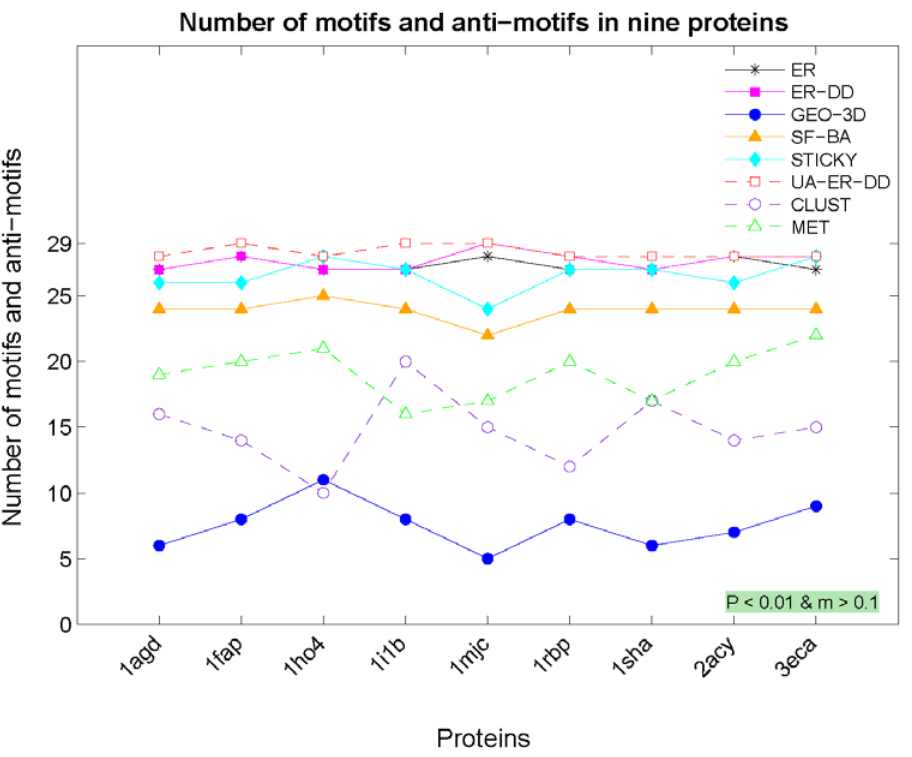
Figure 3. Motif counts for RIGs in Data Set 1 using different network null models. The total number of motifs and anti-motifs identified in nine RIGs corresponding to the nine proteins (1adg, 1fap, 1ho4, 1i1b, 1mjc, 1rbp, 1sha, 2acy, and 3eca), constructed with ‘‘ALL’’ contact type and 5.0 A˚ distance cut-off. The motifs and anti-motifs were identified with respect to the eight network models (ER, ER-DD, GEO-3D, BA-SF, STICKY, UA-ER- DD, CLUST, and MET). The threshold values used for motif selection are displayed within the colored textbox ( P -value lower than 0.01 and M -factor greater than 0.1).